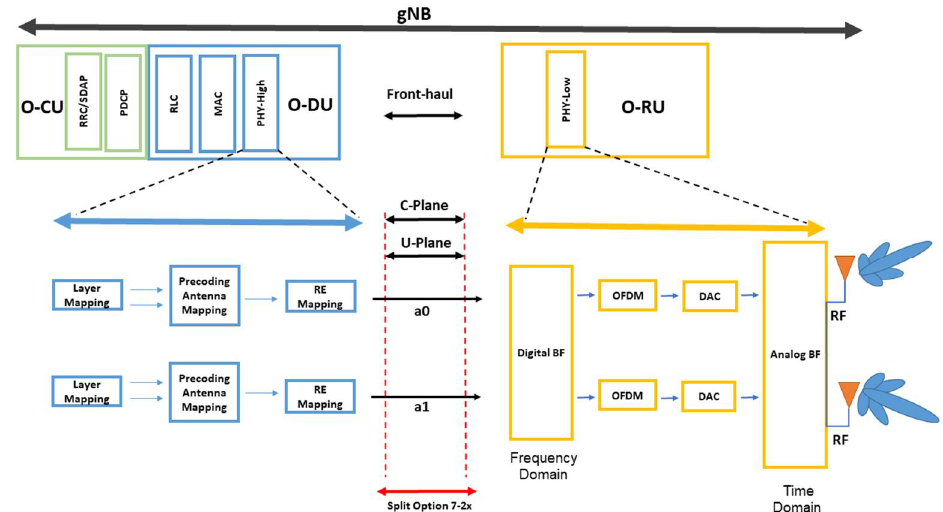
Figure 5. Hybrid beamforming block diagram in O-RAN.